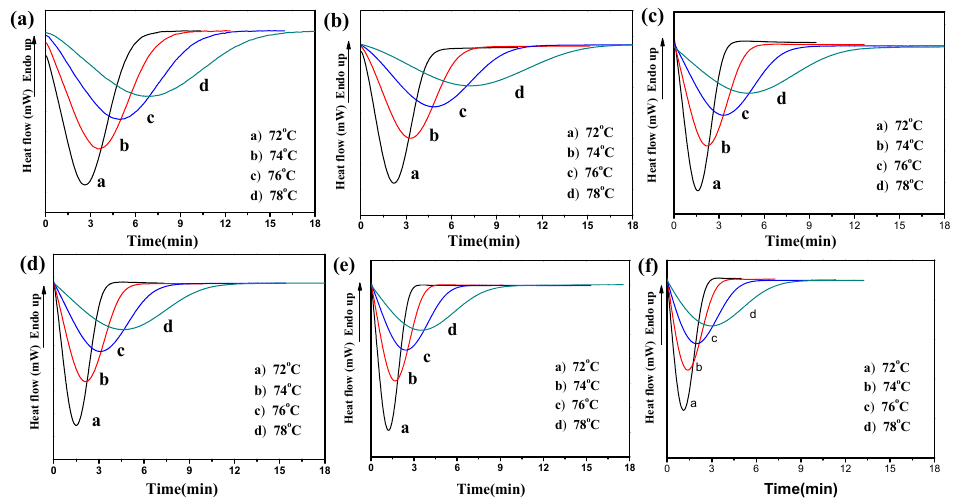
Figure 5. Differential scanning calorimetry (DSC) thermograms of ( a ) PBS, ( b ) PBS/MBF (98/2), ( c ) PBS/BF (95/5), ( d ) PBS/MBF (95/5), ( e ) PBS/MBF (90/10), and ( f ) PBS/MBF (85/15) at different crystallization temperatures.